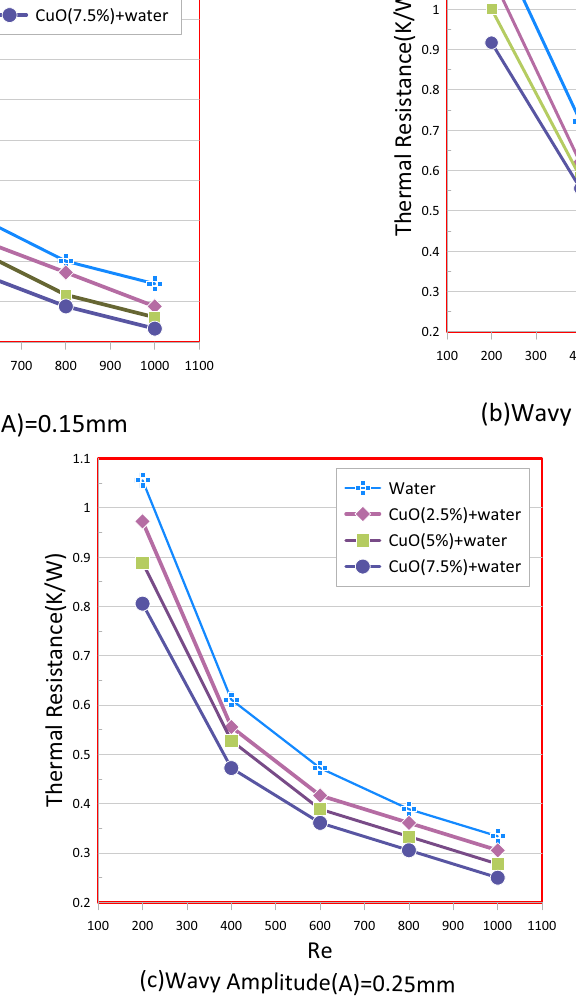
Figure 12. Thermal resistance versus Reynolds Number for wavy channel: ( a ) Wavy Amplitude (A = 0.15 mm). ( b ) Wavy Amplitude (A = 0.2 mm). ( c ) Wavy Amplitude (A = 0.25